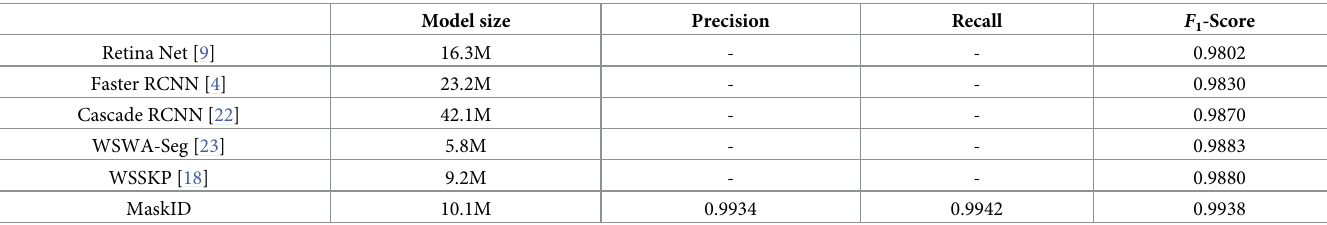
Table 2. Average Precision, Recall and F 1 -score on 200 testing images from DataFountain competition dataset. Model